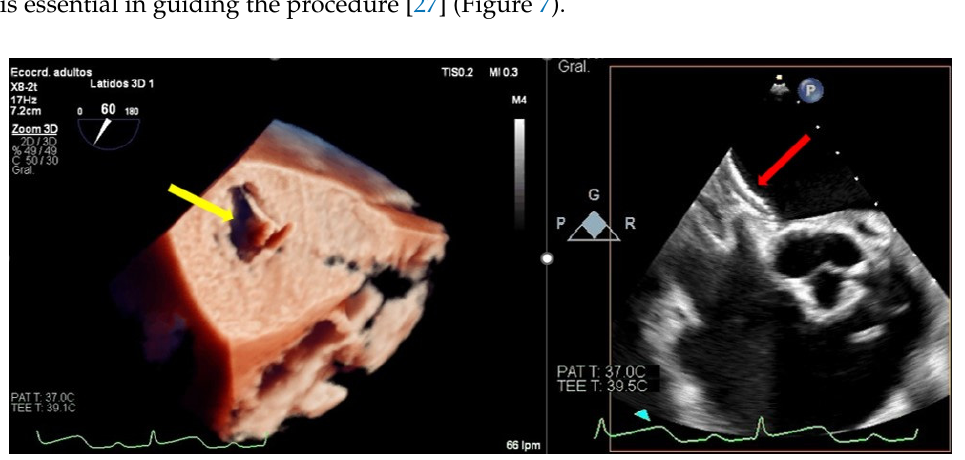
Figure 7. Persistent atrial septal defect. ( Left ) Three-dimensional transesophageal echocardiogram image showing a large atrial septal defect with tearing of the tissue through the transseptal puncture area (yellow arrow) from the left atrium. ( Right ): Two-dimensional transesophageal echocardiogram showing an Amplatzer device closing the iatrogenic atrial septal defect (red arrow).